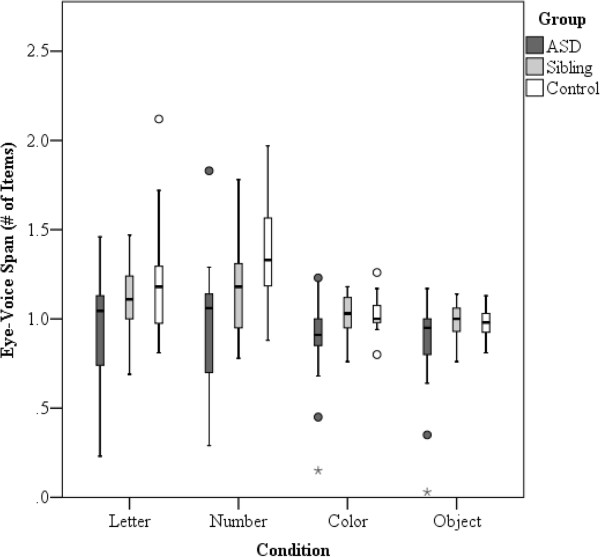
Box plot displaying distribution of eye-voice span (# of items) across groups for the four RAN conditions. The interquartile range (IQR), between the 25th and 75th percentile, is indicated by the lower and upper boundaries of each box, respectively. The horizontal line indicates the median value. Outliers (values 1.5–3 IQRs from the end of the box) are denoted by a circle, and extreme values (values >3 IQRs from the end of the box) are marked by an asterisk.